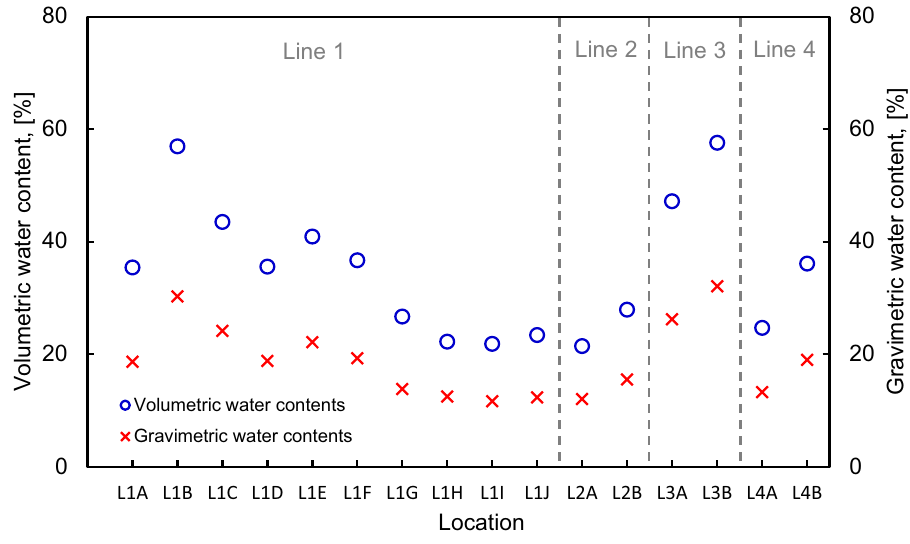
Figure 6. Distributions of volumetric and gravimetric water contents.